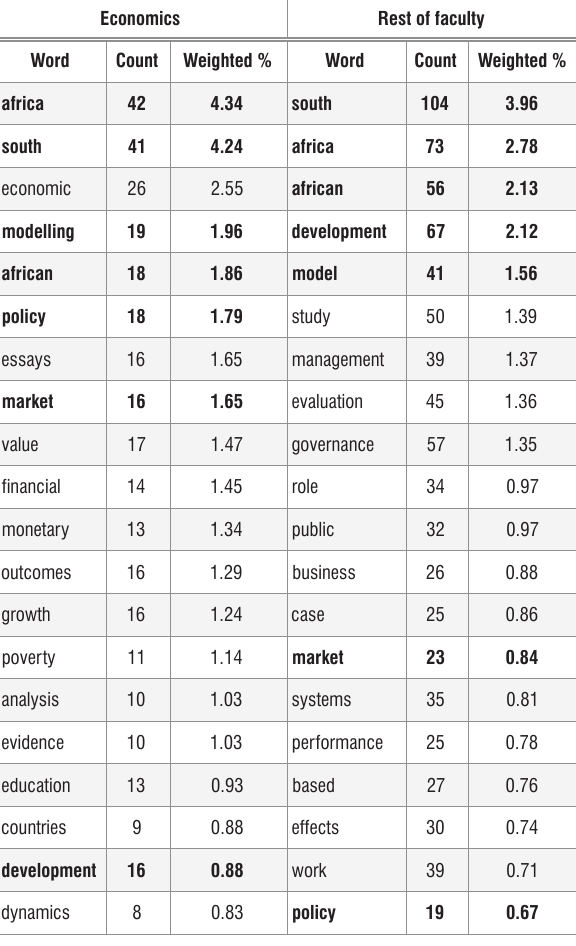
Word frequencies (top 20) in the titles of doctoral theses at the Universities of Cape Town, Pretoria, Stellenbosch and the Witwatersrand